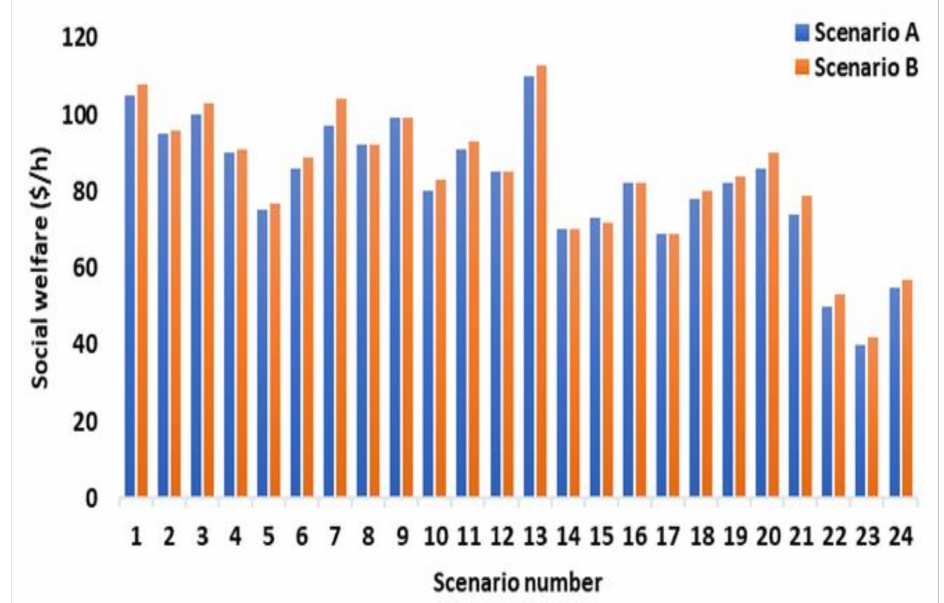
Figure 11. Social welfare for each